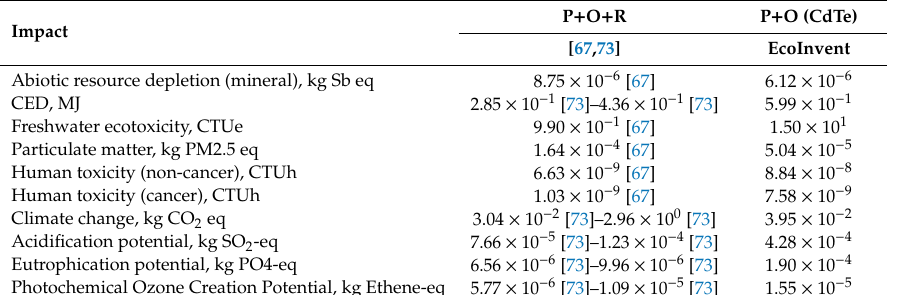
Table 4. Environmental impacts of di ff erent life cycle stages of CdTe PV panels (for 1 kWh 3